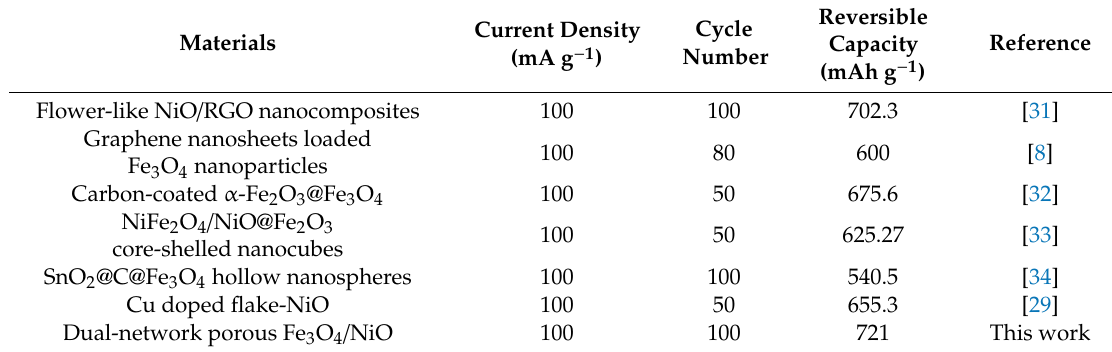
Table 1. The comparison of Li-ion storage performance among di ff erent